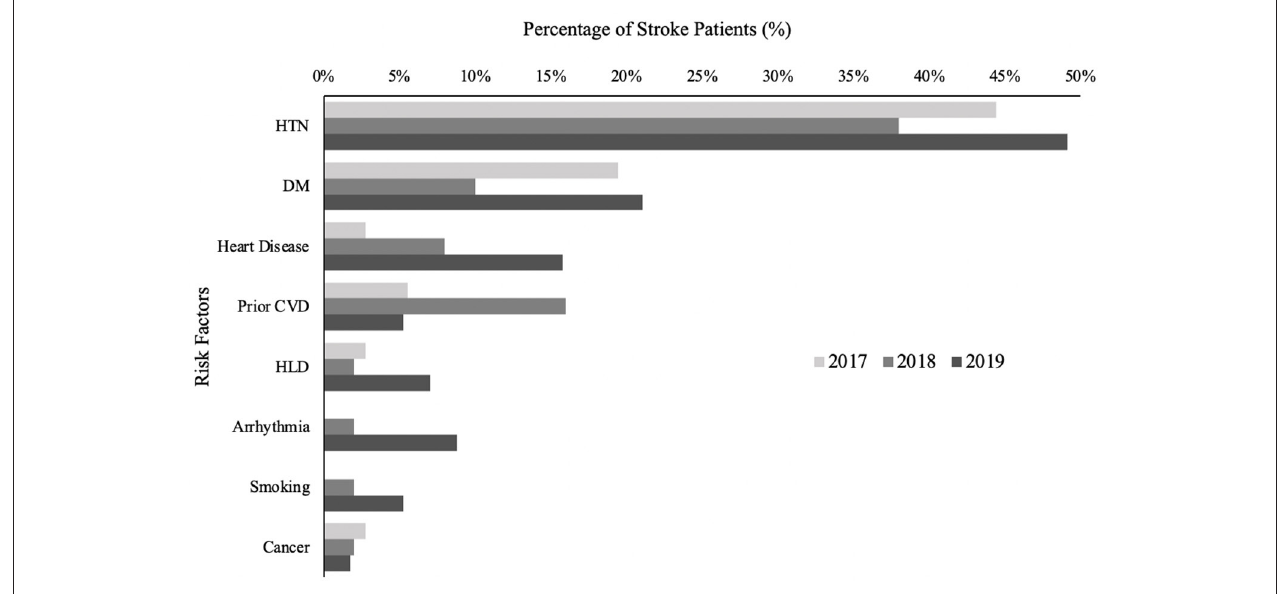
FIGURE 1 | Stroke risk factors, %. Percentage of study population with given stroke risk factor. Prior CVD includes both stroke and TIA. Heart disease includes coronary artery disease, ischemic cardiomyopathy, valvular cardiomyopathy, dilated cardiomyopathy, and congenital cardiomyopathy. Arrhythmias include atrial fibrillation and supraventricular tachycardia.